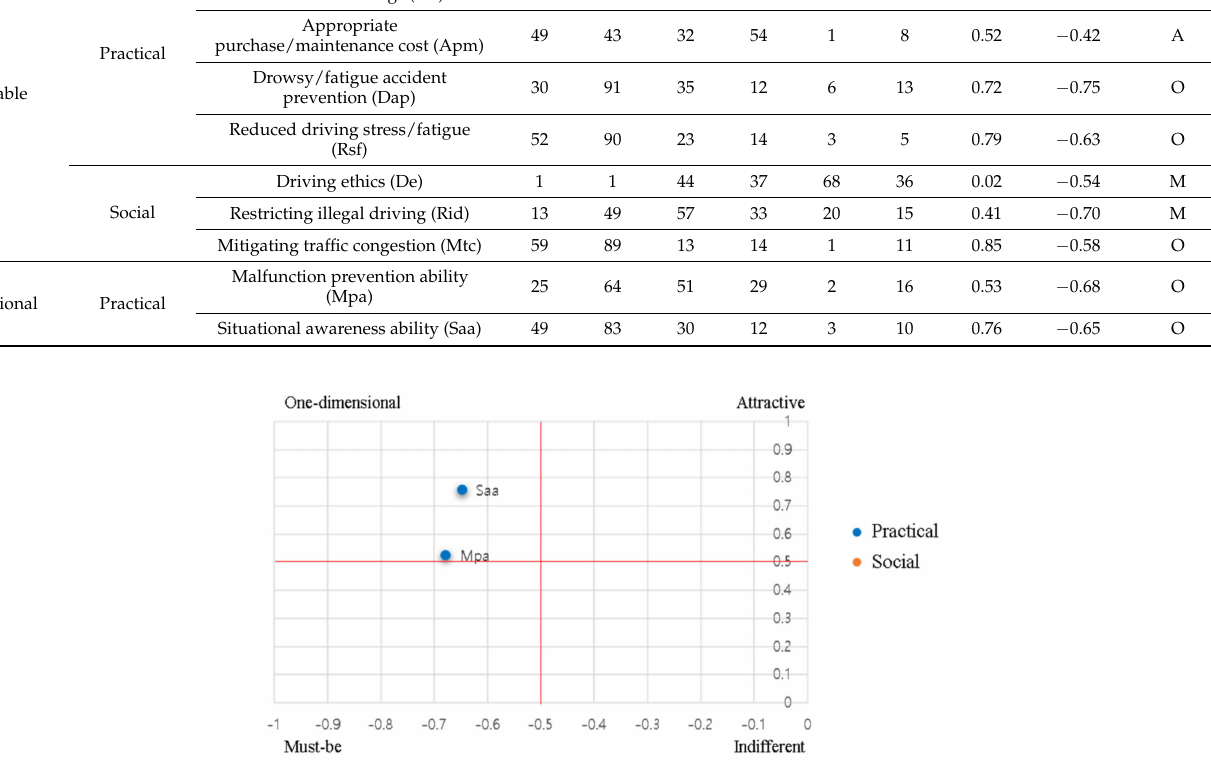
Figure 4. Factor positions for functional